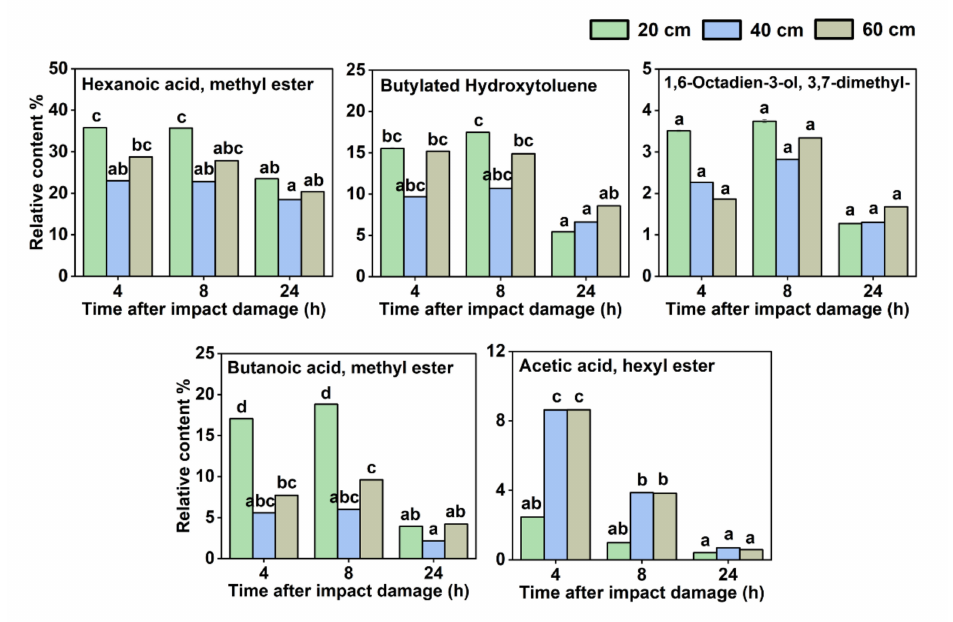
Figure 6. Five VOCs whose relative contents decreased with increasing storage time after impact onset. Different letters (a, b, c, d) indicate significant differences ( p <